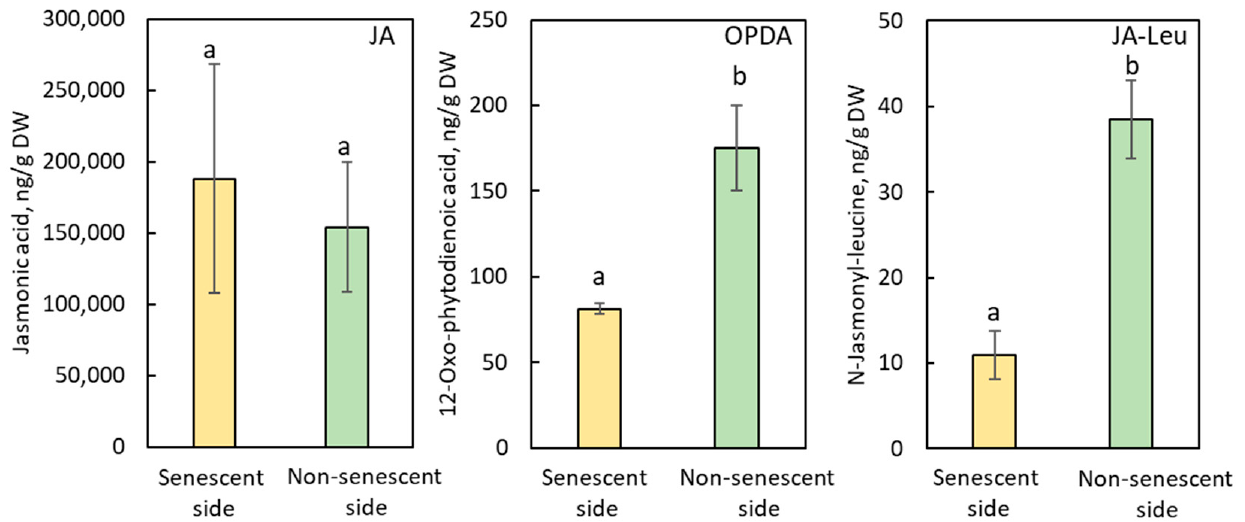
Figure 3. Endogenous levels of jasmonate ‐ related compounds in the senescent and non ‐ senescent sides of the SAZ induced by JA ‐ Me in the internode explants of Bryophyllum calycinum . JA: jasmonic acid; OPDA: 12 ‐ oxo ‐ phytodienoic acid; JA ‐ Leu: N ‐ jasmonyl ‐ leucine. Values are the mean with standard error (n = 6). Different letters on the column (a, b) indicated statistically significant at p < 0.05 after ANOVA.